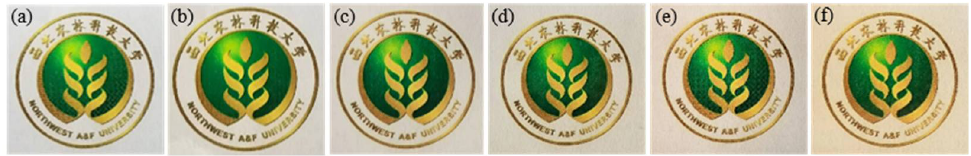
Figure 4. Digital photographs of the films, ( a ) SA-TA 0, ( b ) SA-TA 1, ( c ) SA-TA 2, ( d ) SA-TA 3, ( e ) SA-TA 4, ( f ) SA-TA 5.